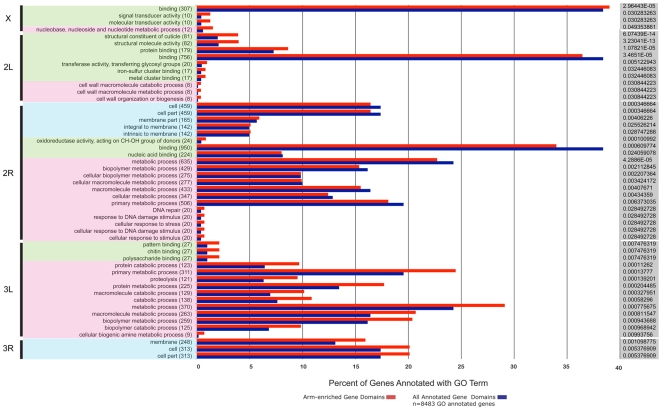
Overrepresented GO terms enriched on each chromosomal arm of the An. gambiae genome assembly.The percentages of arm-enriched (red) genes containing the listed GO biological process (pink shading), cellular location (blue shading), and molecular function (green shading) terms are compared to the percent of genes in the whole genome matching that term. Numbers in parentheses refer to the actual number of arm-enriched genes annotated with the listed GO domain. P-value significance scores, as determined by GO-Term-Finder, are shown to the right (grey shading).